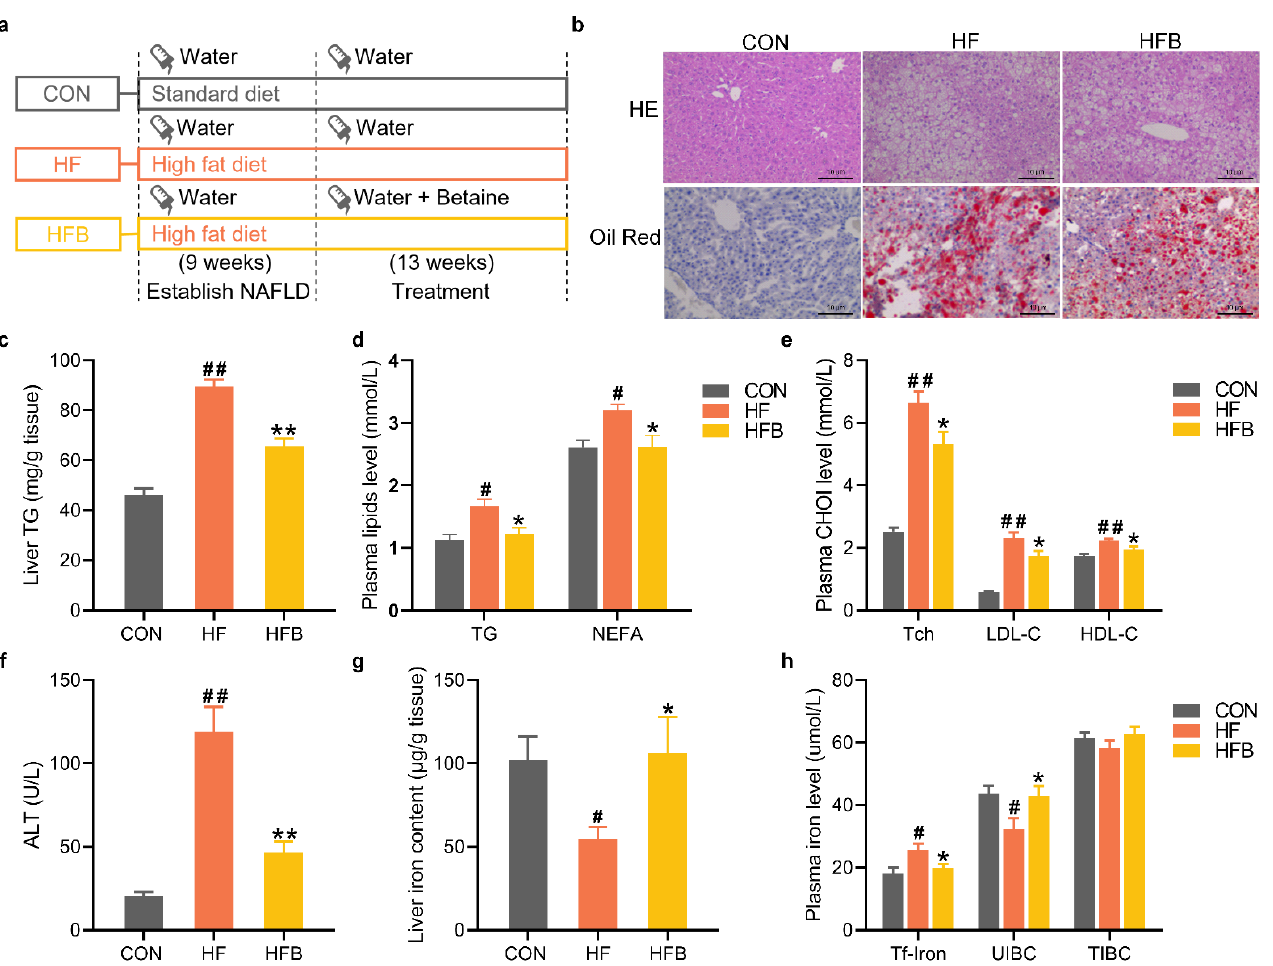
Figure 1. Phenotypic characterization of fatty liver syndrome and liver iron disorder in liver and plasma. ( a ) Flow chart of the experimental design. ( b ) HE staining of hepatic sections ( n = 3) and ORO staining of hepatic sections ( n = 3). ( c ) Hepatic content of TG ( n = 8). ( d ) Plasma level of TG and NEFA ( n = 8). ( e ) Plasma level of Tch, LDL-C and HDL-C ( n = 8). ( f ) Plasma level of ALT ( n = 8). ( g ) Hepatic content of iron ( n = 8). ( h ) Plasma level of Tf-iron, UIBC and TIBC ( n = 8). Values are means ± SEM. # p < 0.05 and ## p < 0.01 compared with the CON group. * p < 0.05 and ** p < 0.01 compared with the HF group.